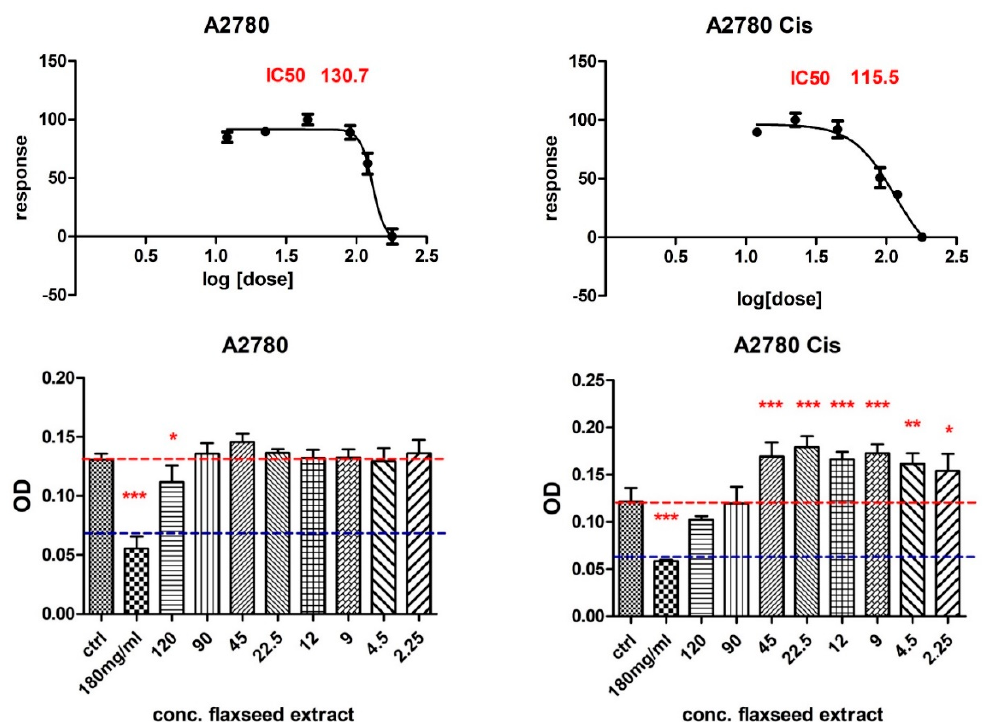
Figure 3. The viability response of ovarian epithelial carcinoma cells A2780 and A2780cis at different concentrations of flaxseed extract (MTT assay), where p ≤ 0.05 (*), p ≤ 0.01 (**), and p ≤ 0.001 (***) as compared with control. Human fibroblasts and human endothelial cells from the umbilical vein also showed different behaviour: endothelial cells were found to be more sensitive regarding cytotox- icity, even at lower doses of flaxseed extract (Figure 5).